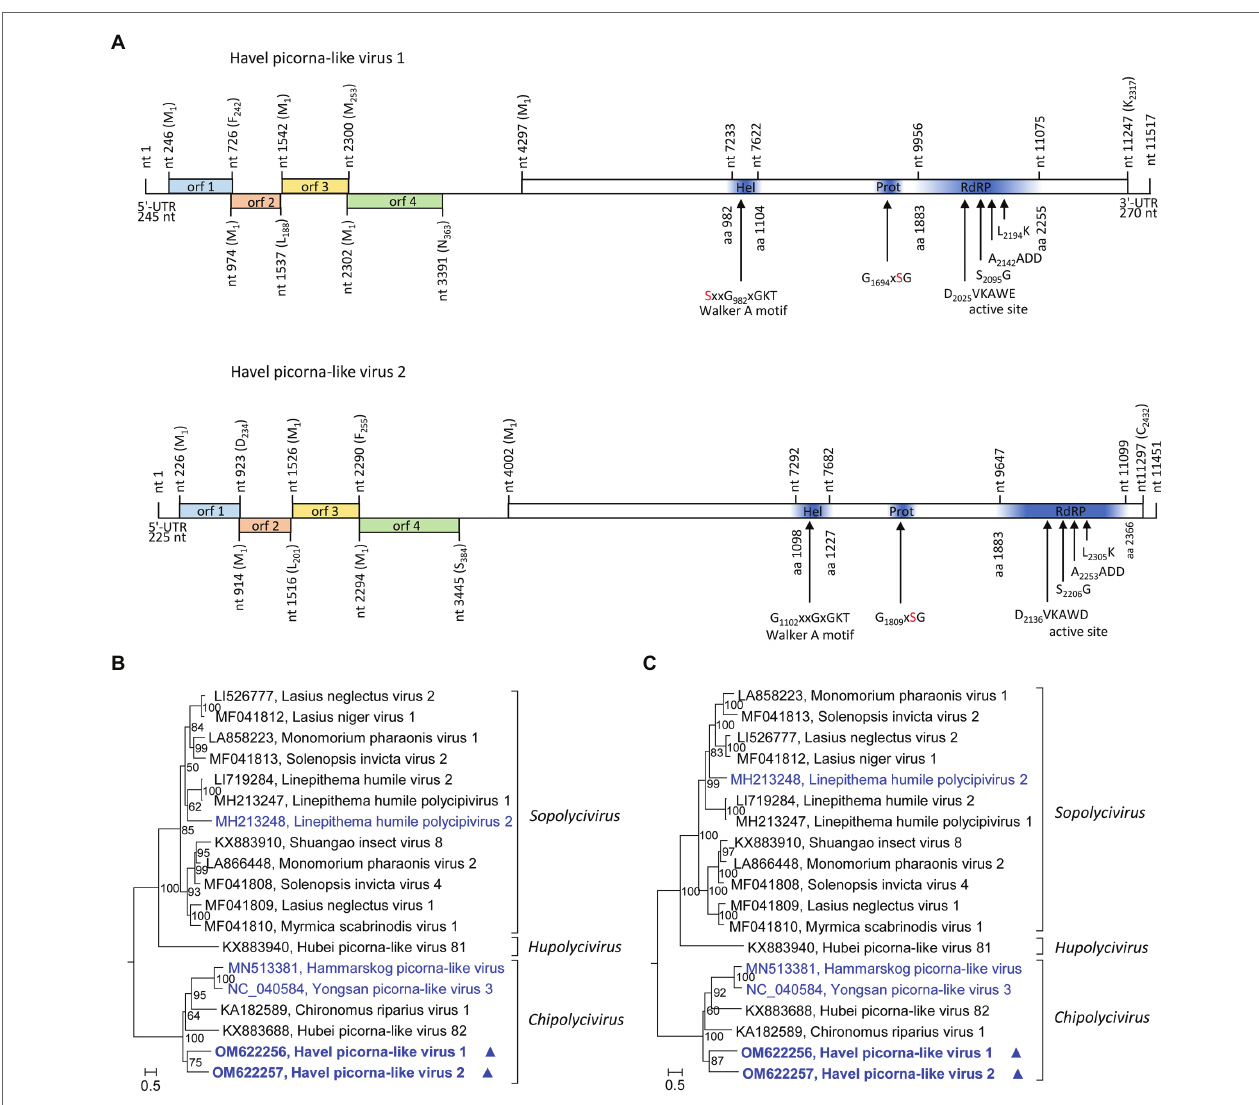
FIGURE 5 | Analysis of Havel picorna-like viruses 1 and 2. (A) Genome organization of Havel picorna-like virus 1 (top) and 2 (below). Conserved domains and sequence motifs were identified by searching the NCBI Conserved Domain Database (https://www.ncbi.nlm.nih.gov/Structure/cdd/wrpsb.cgi). Phylogenetic analyses of the concatenated capsid proteins-encoding ORFs 1, 3, and 4 (B) and the helicase, proteinase, and polymerase gene regions of ORF5 (C) . Sequences of 17 polycipivirus strains plus Havel picorna-like virus 1 and 2 were included. The tree was inferred with IQ-Tree 2; optimal substitution model: GTR + F + R4 in both analyses. Presented are GenBank acc. nos. and virus names. The respective genera are presented to the right. Unassigned viruses are printed in blue. A triangle ( ▲ ) indicates the viruses of the present study. Numbers at nodes indicate bootstrap values obtained after 50,000 ultrafast bootstrap replications. The scale indicates substitutions per site. orf, open reading frame; UTR, untranslated region; Hel, helicase; Prot, proteinase; and RdRP,